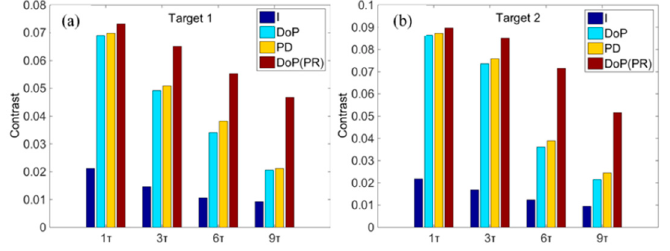
Figure 6. The contrast of Target 1 ( a ) and Target 2 ( b ) with di ff erent imaging methods and di ff erent optical